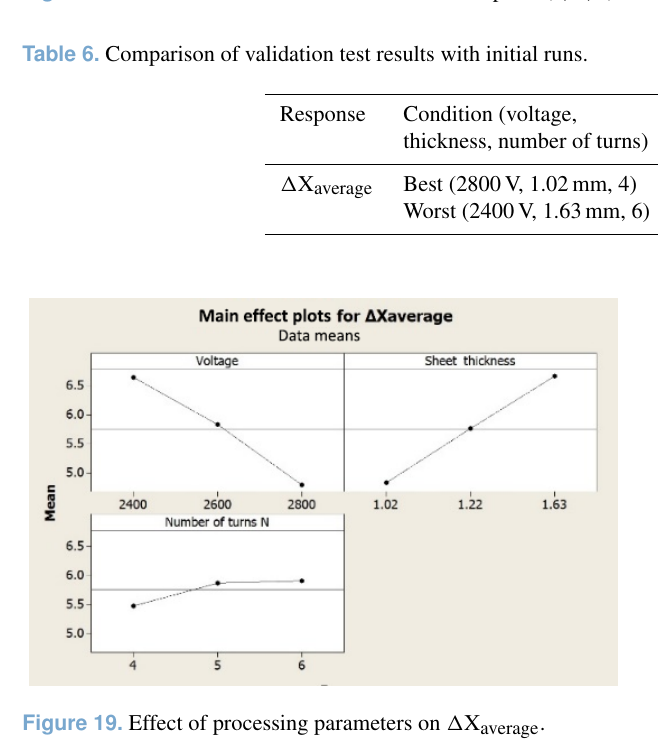
The average gap between the die profile and deformed sheet height was obtained at three points a, b and c as shown in Fig. 18. (cid:49) X 1 , (cid:49) X 2 and (cid:49) X 3 represent the gap between the die and deformed sheet at points a, b and c respectively. (cid:49) X average shows the average of (cid:49) X 1 , (cid:49) X 2 and (cid:49) X 3 . A and vice